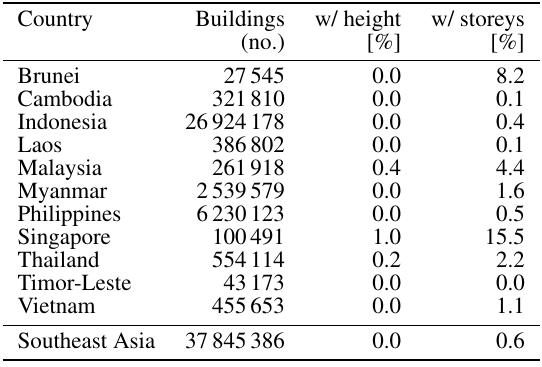
Table 1. Country-level analysis of the completeness of vertical attributes of buildings in